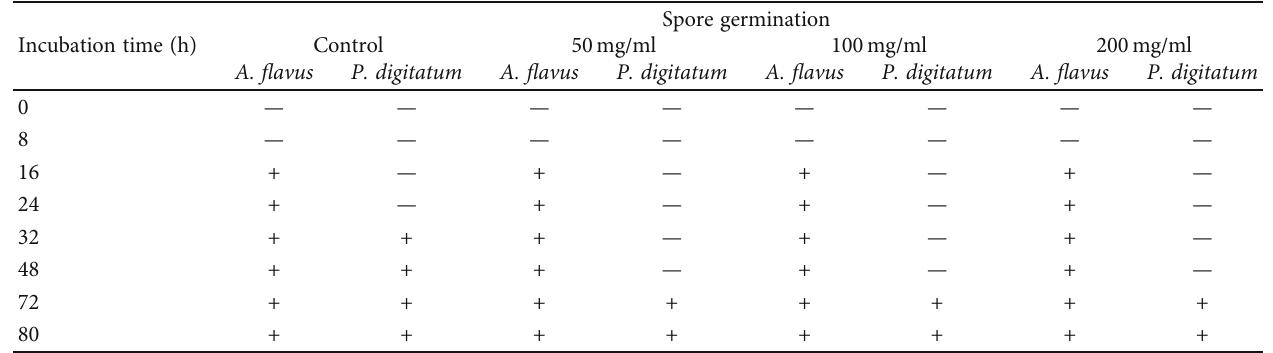
Table 4: E ff ect of Mao fruit juice on spore germination of A. fl avus and P. digitatum.